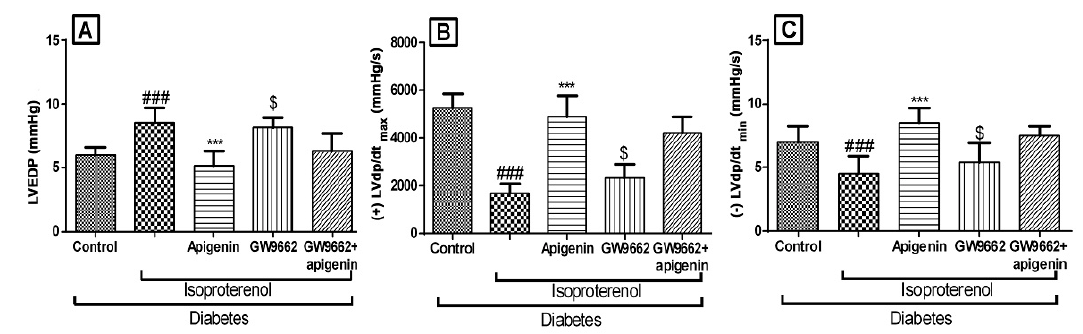
Figure 3. Effects of apigenin on peak positive and negative pressure development in STZ–isoproterenol-treated rats. ( A ) Left ventricular end diastolic pressure (LVEDP), ( B ) Maximal positive rate of left ventricular pressure (+LVdp/dt max ), ( C ) Maximal negative rate of left ventricular pressure ( − LVdp/dt min ). The data are expressed as the mean ± SEM. The significance was determined by one-way ANOVA followed by the Bonferroni’s post hoc test: *** p < 0.001 compared to diabetic isoproterenol; ### p < 0.001 compared to diabetic control; $ p < 0.001 compared to diabetic isoproterenol + apigenin.